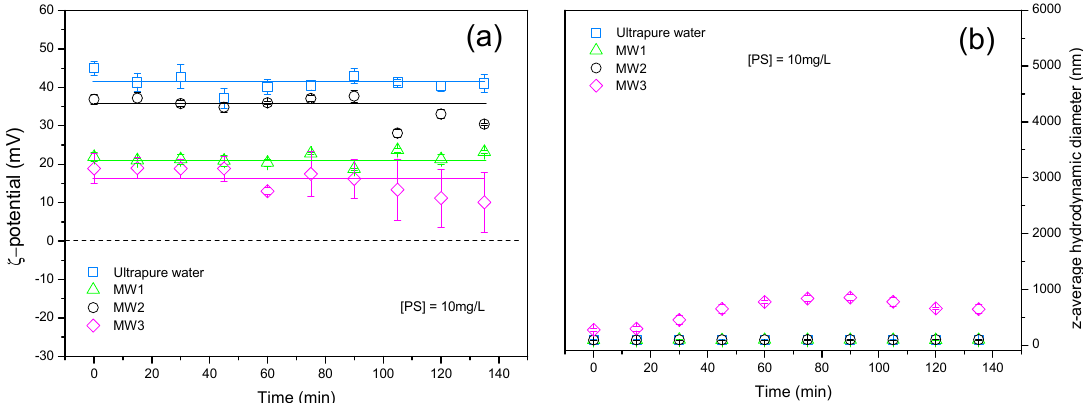
Figure 8. ( a ) ζ potential and ( b ) z-average hydrodynamic diameter variation of amidine PS nanoplastic particles as a function of time in ultrapure at pH = 7.0 ± 0.1 and mineral waters at their natural pHs. A decrease of ζ potential is observed for all mineral waters. However, nanoplastics are stable and no aggregation is observed. Limited aggregation is only observed for